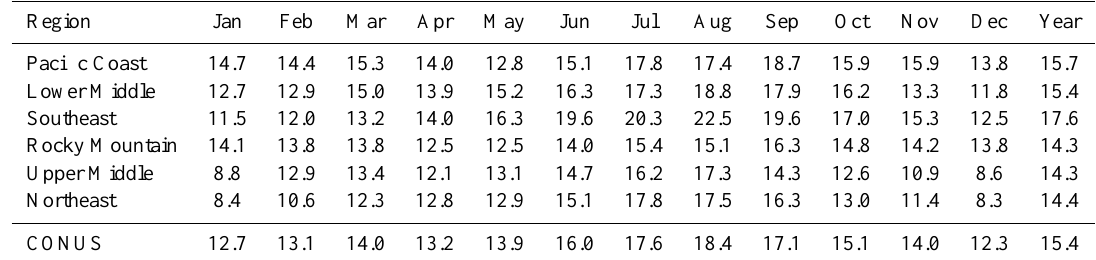
Upper Middle − 3.0 Northeast − 1.0 − 5.6 CONUS 2.9 Table 2. Monthly and annual average ozone RMSEs in different regions and CONUS in 2010. Unit: ppbv. Region Jan Pacific Coast Lower Middle Southeast Rocky